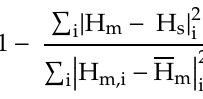
Figure 22. Time-step information of the simulation.